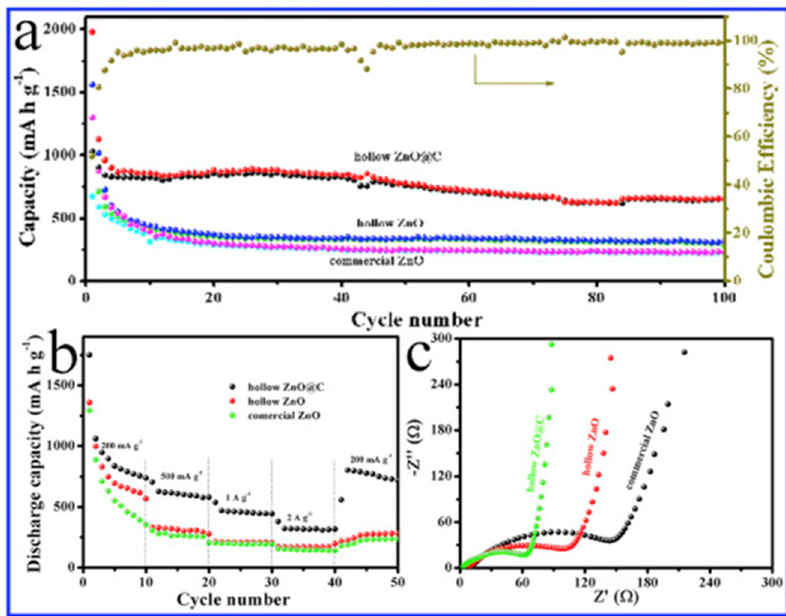
Figure 11. ( a ) Capacity of hollow ZnO/C, hollow ZnO, commercial ZnO ( b ) Charging/discharging capacity ( c ) impedance spectra of same materials [67]. Reproduced with permission.